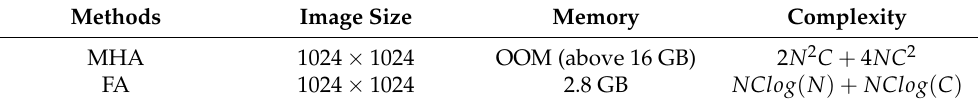
Figure 4. The illustration of a structure of dense fusion and the proposed Fourier attention (FA). Table 1. The complexity comparison of Fourier attention (FA) and multi-head attention